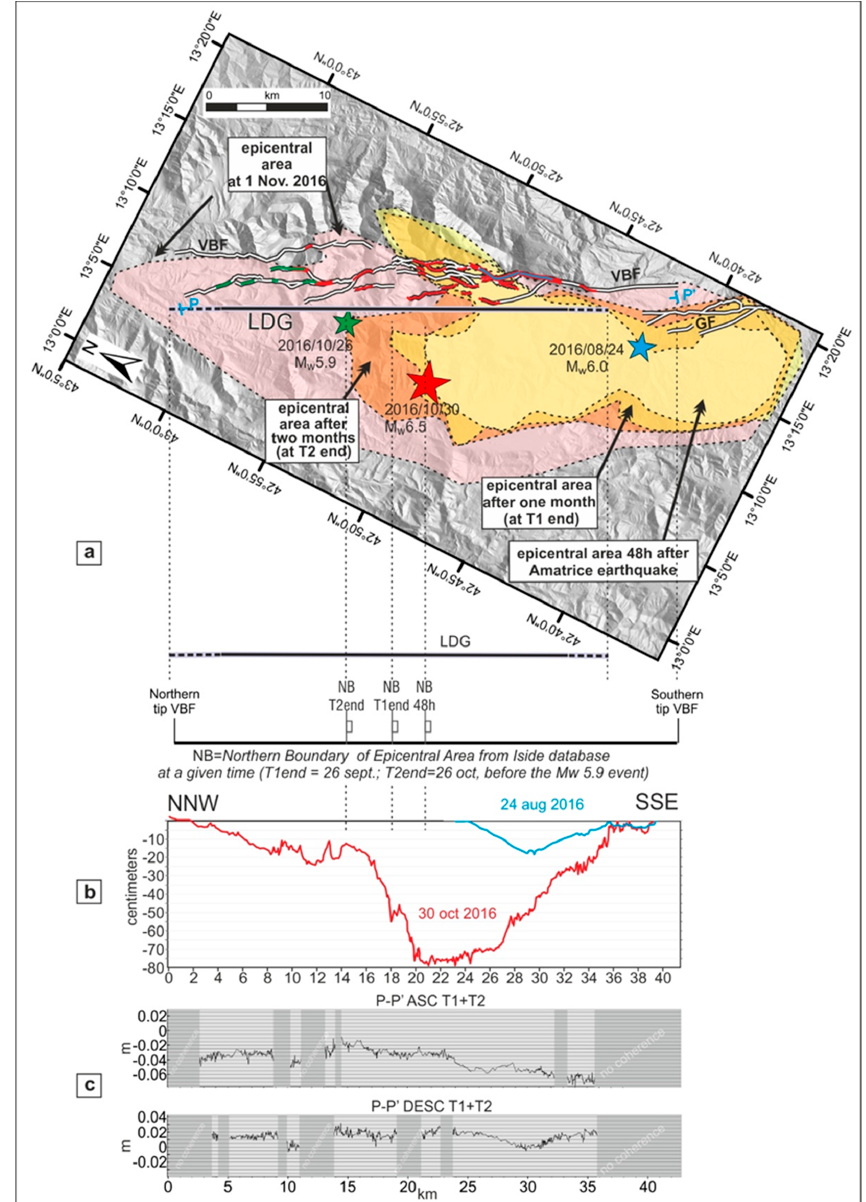
Figure 7. Coseismic and intra-sequence deformations compared to the spatial evolution of seismicity and major earthquake epicenters. ( a ) Map showing Length of Deforming Ground (LDG) (black-violet line) in the hanging wall of the Mt Vettore-Mt Bove Fault (VBF) as interpreted from the Intra-sequence Ground Deformation (IGD) pattern shown in the interferograms in Figures 3 and 4. The continuous black-violet line shows the minimum extent of the LDG (LDGm), whereas the continuous black-violet line plus dotted segments shows the maximum extent of LDG (LDGM) (Section 2.3). A comparison to Figure 3a,c shows that during the first intra-sequence period (T1, from 27 August to 26 September), the IGD was already affecting a large part of the VBF hanging wall. The LDG anticipated the extent of the (future) surface rupture caused by the Mw 5.9 foreshock and Mw 6.5 mainshock (red and green lines along the VBF trace). The colored areas show envelopes of